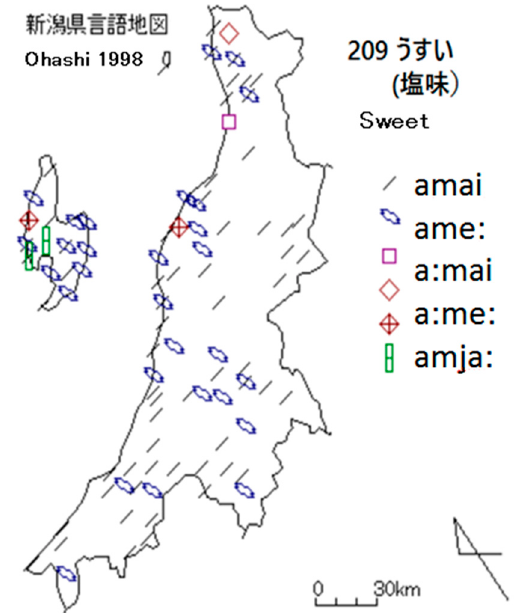
Figure 7. Map of amai “sweet, not salty” from Ohashi (1998).